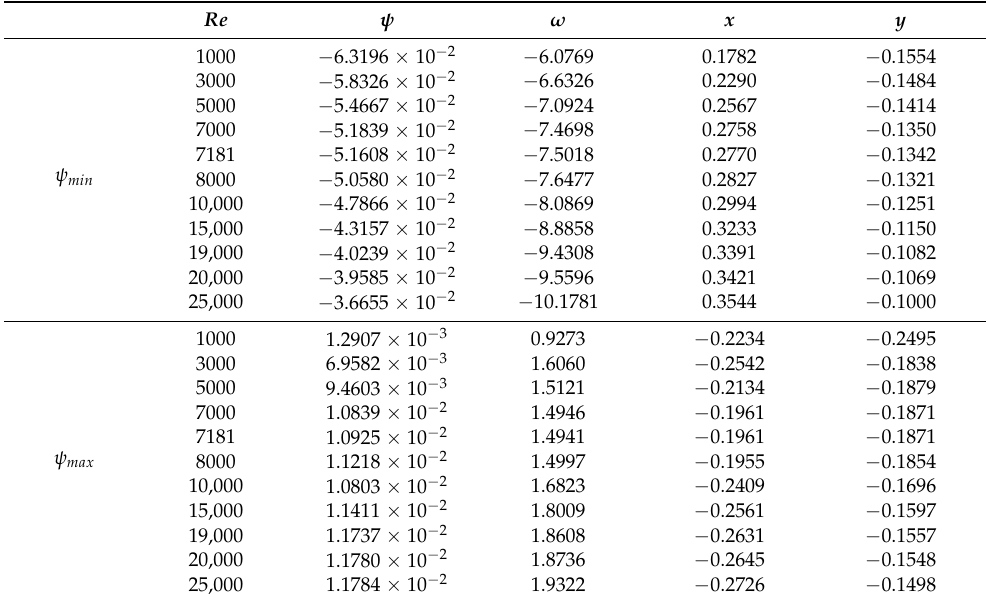
Table 7. Minimum and maximum streamfunction values in the 1st solution, corresponding vorticity values and ( x , y ) locations for D = 0.80.